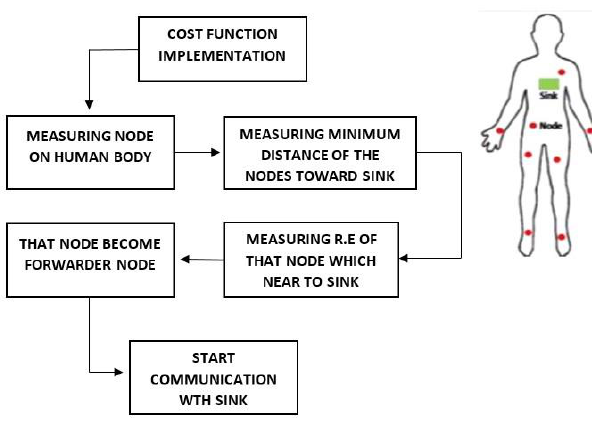
Fig. 2. Cost function